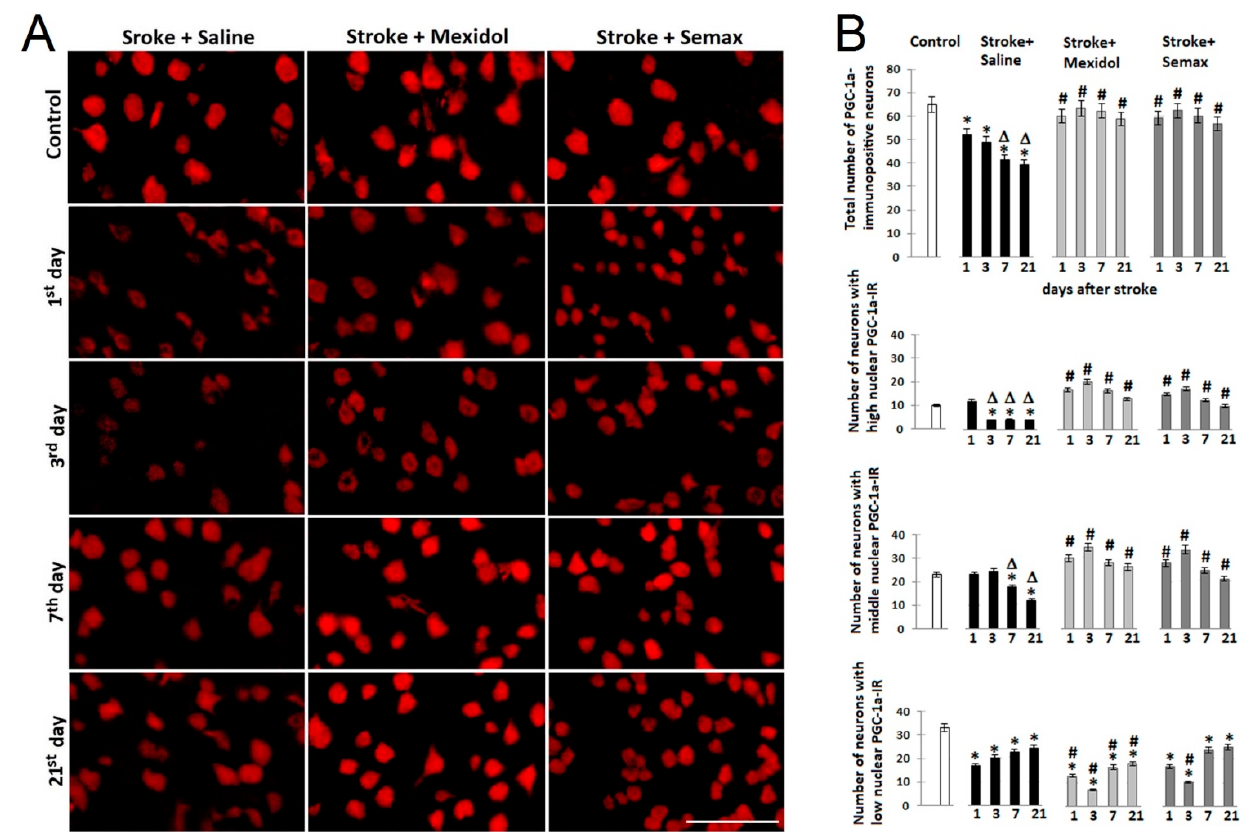
Figure 7. Effect of a 7-day treatment course of Mexidol and Semax on the expression and nuclear localization of PGC-1 α in penumbral neurons at 1, 3, 7, and 21 days after PT of the prefrontal cortex. ( A ) Representative microphotographs of the immunohistochemical staining of rat prefrontal cortex slices. Bar: 50 μ m. ( B ) Diagrams showing the number of PGC-1 α -immunopositive neurons and neurons with high, middle, and low nuclear PGC-1 α -immunoreactivity. The mean values of the number of cells were obtained by counting six randomized micrographs (images corresponded to the area of a penumbra 0.1 mm 2 ) in three different sections from four rats for each experimental episode; data represent the mean ± SEM. * p < 0.05 denotes a significant difference from the Control group; # p < 0.05 denotes a significant difference from the Stroke + Saline group; Δ p < 0.05 denotes a significant difference from the first postoperative day (intra-group comparisons) based on a two-way ANOVA with Bonferroni’s post-hoc multiple comparison test. PGC-1 α -IR: PGC-1 α -immunoreactivity.